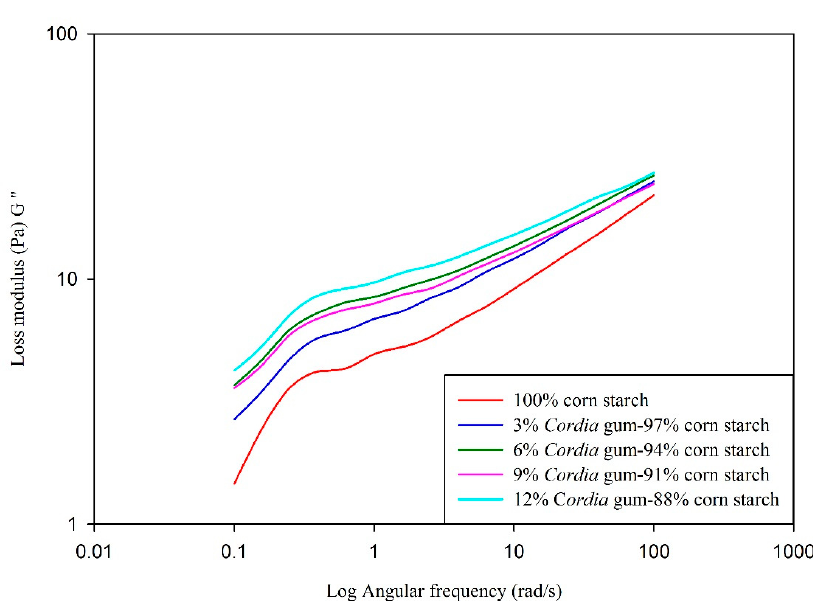
Figure 2. Effect of gum Cordia on the storage (elastic) modulus (G ′ ) of corn starch gels.